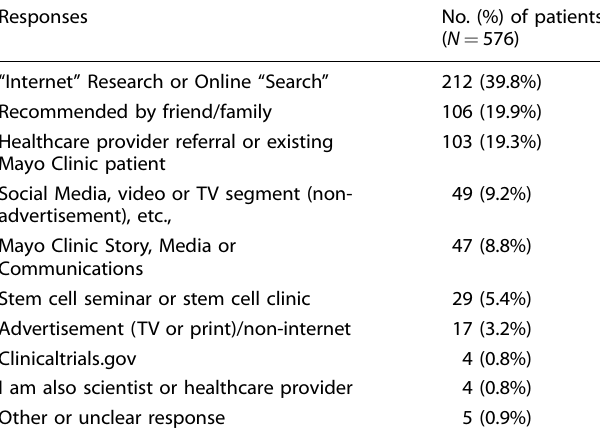
Table 3. Responses for how patients found out about a SCT for their condition.